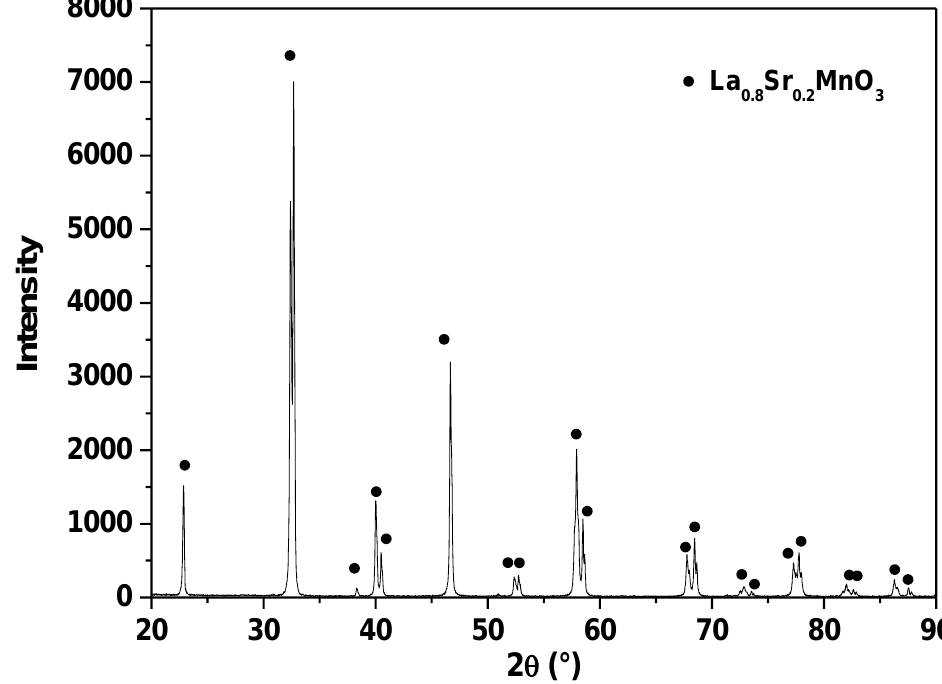
Figure 4. Powder X-ray diffraction pattern of the LSM particles. Table 2. Crystallographic parameters of La 0.8 Sr 0.2 MnO 3 particles.